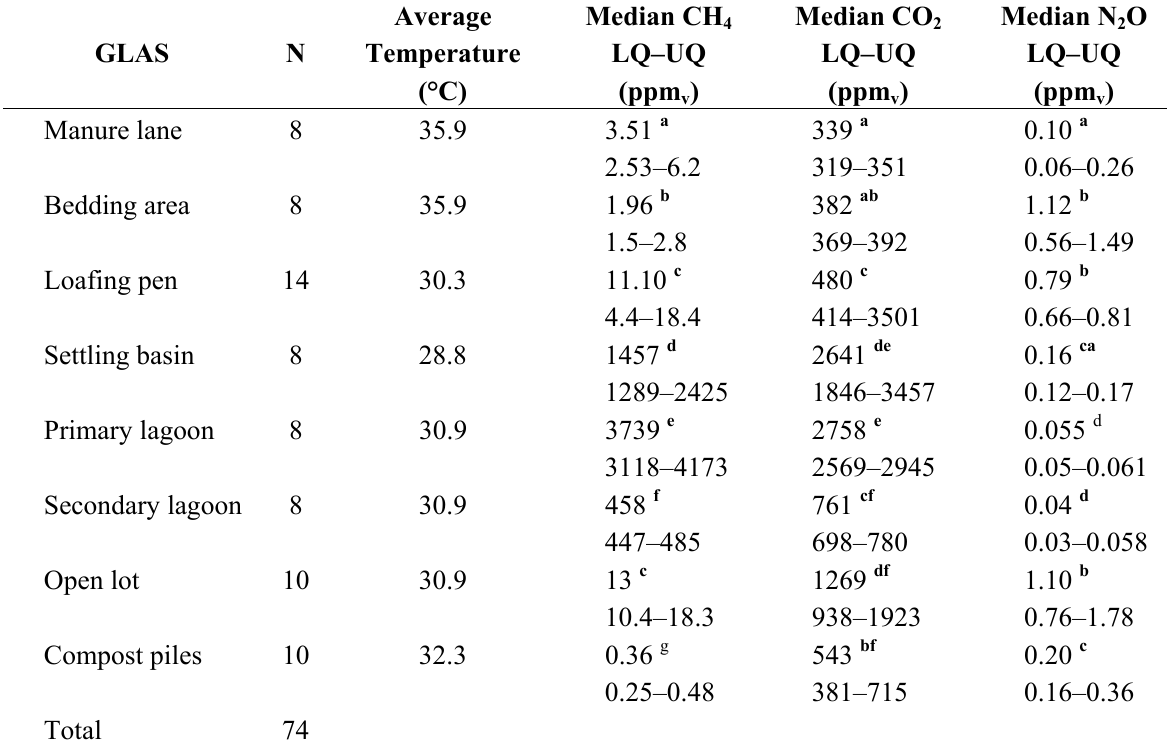
Table 2. Volumetric concentration (median and quartiles) measured from various GLASs in a